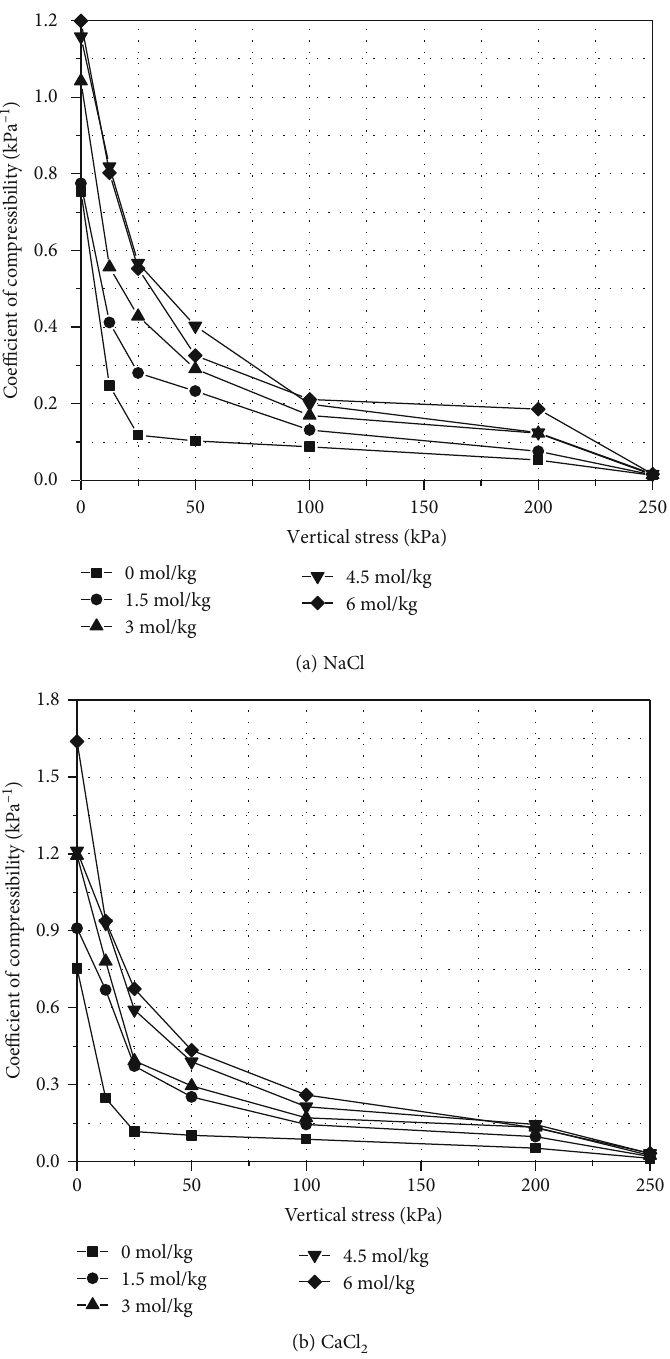
Figure 8: Coe ffi cient of compressibility of saline soil with (a) NaCl and (b) CaCl